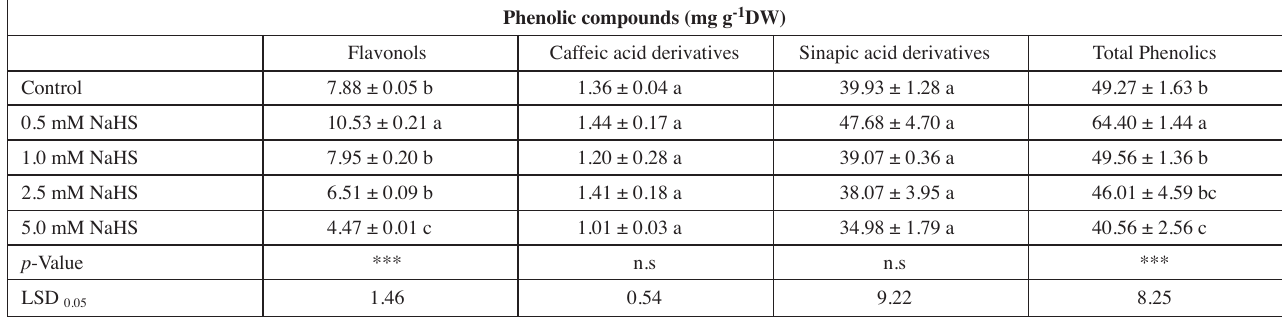
Tab. 3: Effects of different doses of NaHS on phenolic compounds.